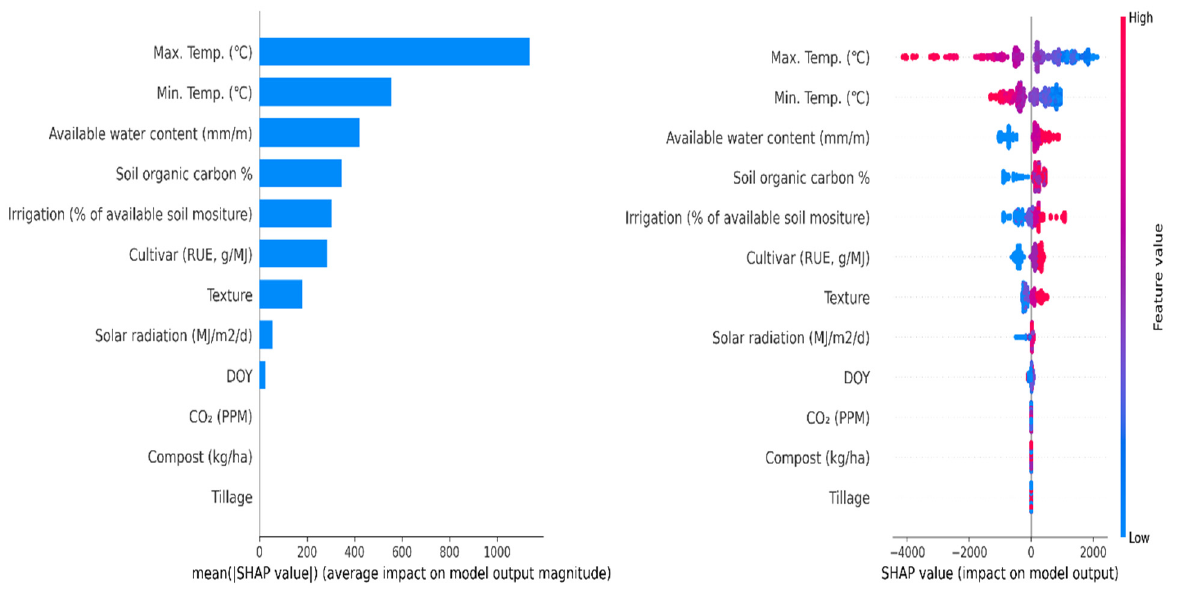
Figure 6. Feature importance for grain yield (kg ha − 1 ) based on SHAP-values for the XGBoost re- gression model. On the left , the mean absolute SHAP-values are depicted to illustrate global feature importance. On the right , the local explanation summary shows the direction of the relationship between a feature and the model output. Positive SHAP-values are indicative of increasing grain yield whereas negative SHAP-values are indicative of decreasing grain yield.